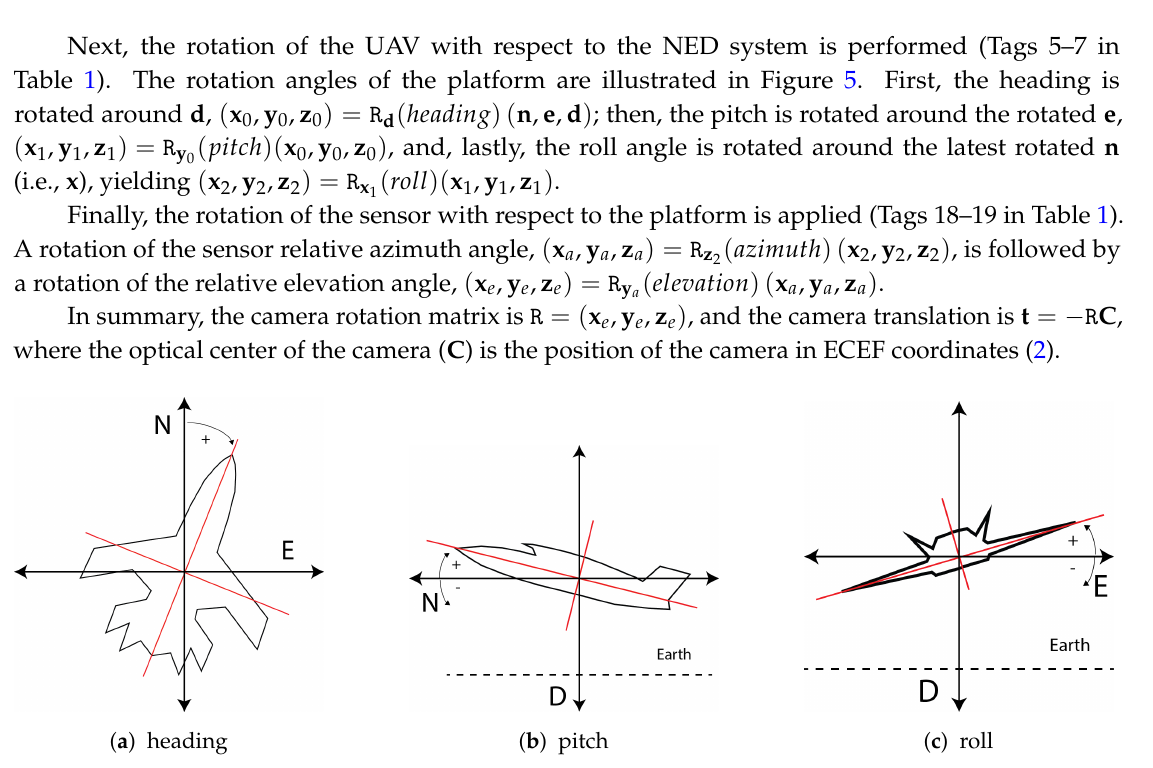
Figure 5. On the left, the heading angle of the platform in the plane N – E . In the middle, the pitch angle of the platform with respect to the plane D – N . On the right, the roll angle of the platform in the D – E